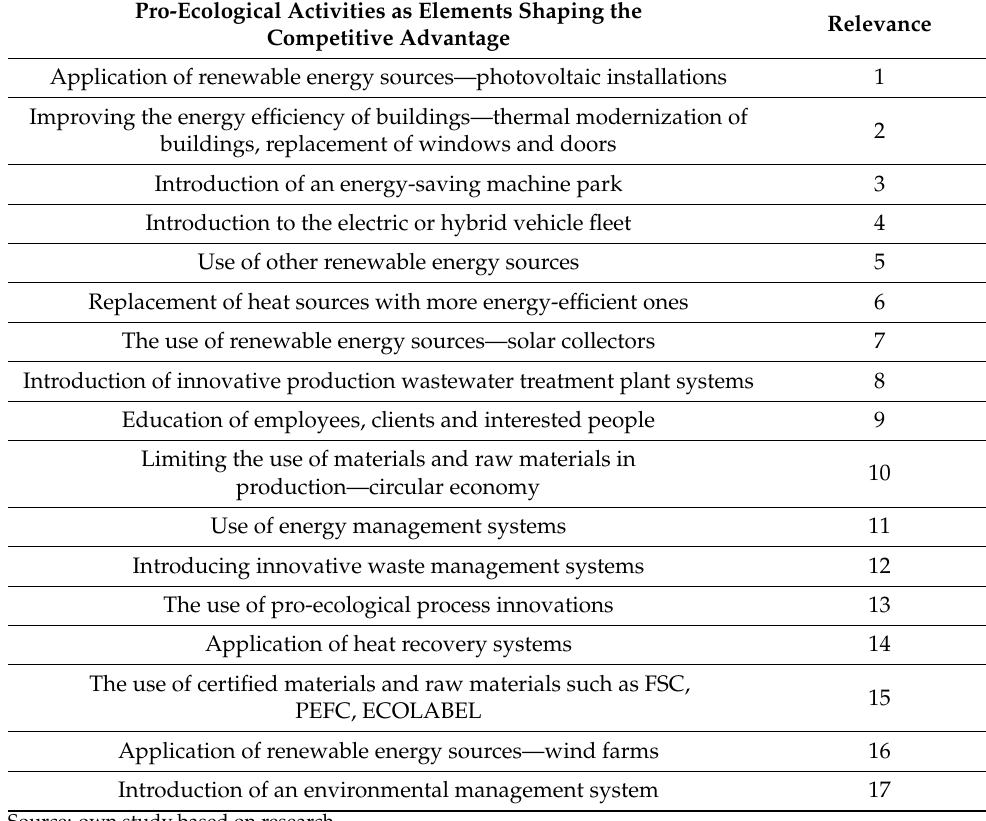
Table 5. Assessment of the significance of pro-ecological activities as elements shaping a competi- tive